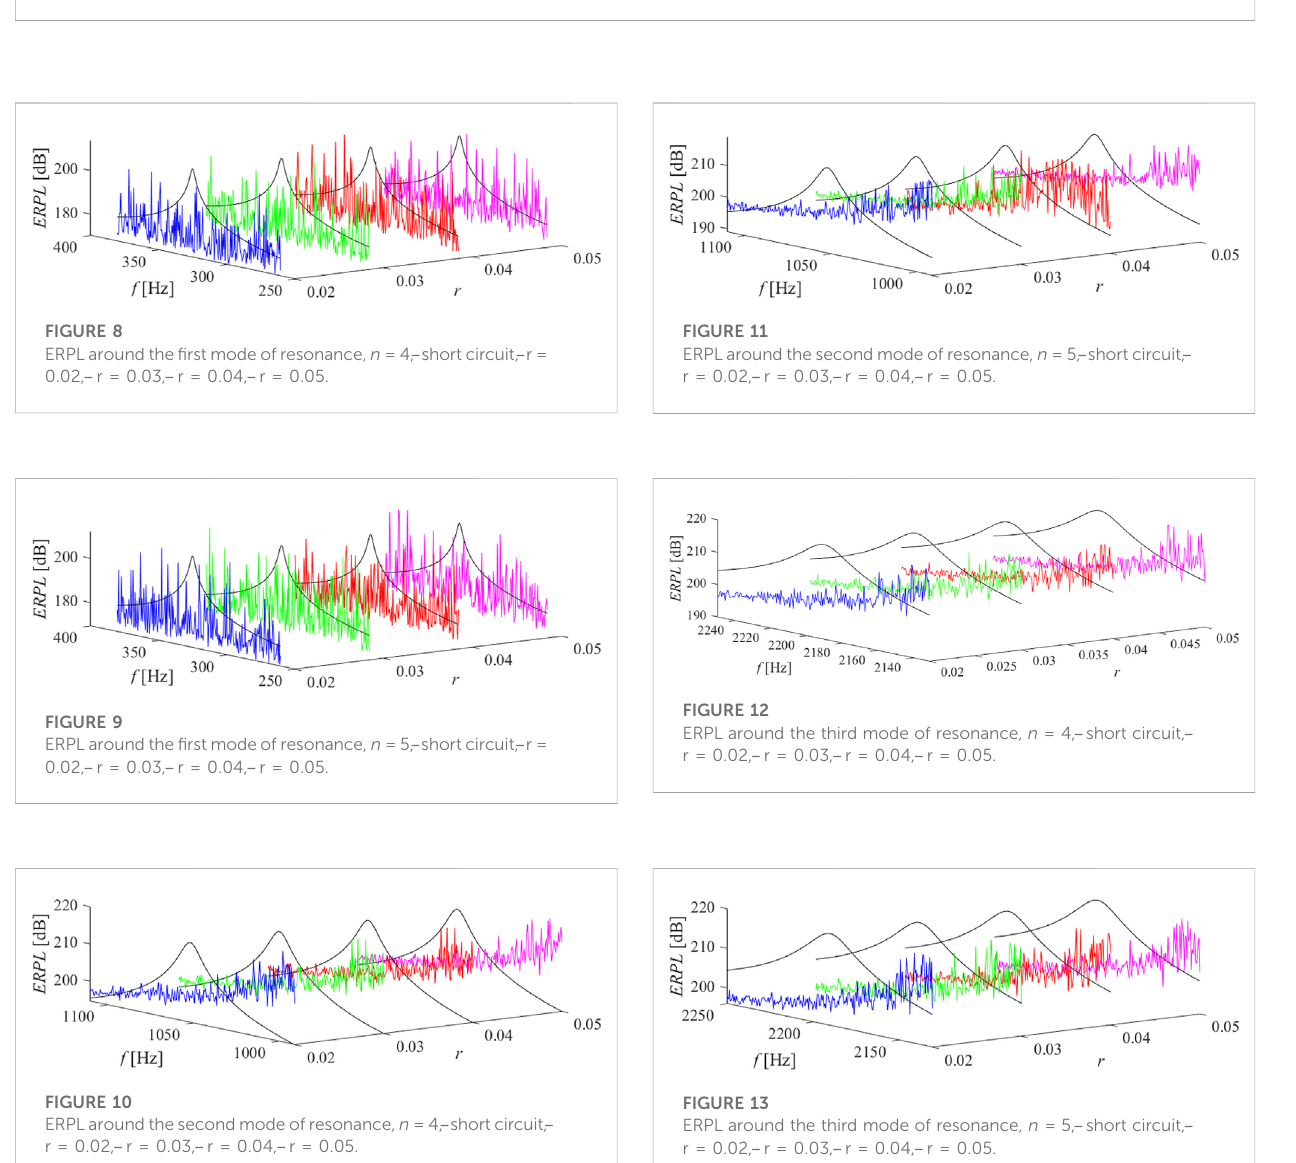
FIGURE 7 (A) Capacitance pro fi les ( r = 0.02, n = 4) adopted for different resonance modes, (B) eigenmode shapes.